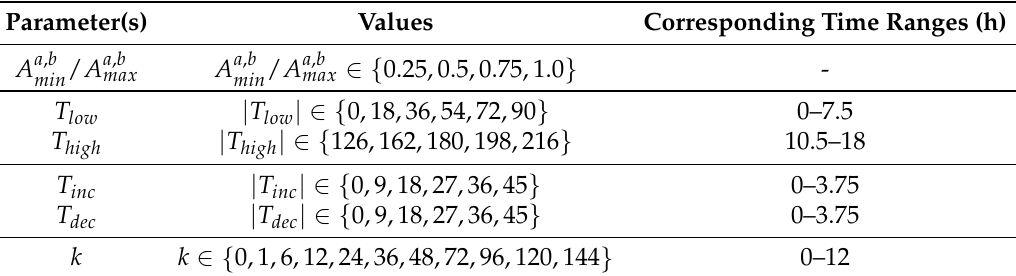
Table 1. Varied parameters of the traffic model with ∆ t =